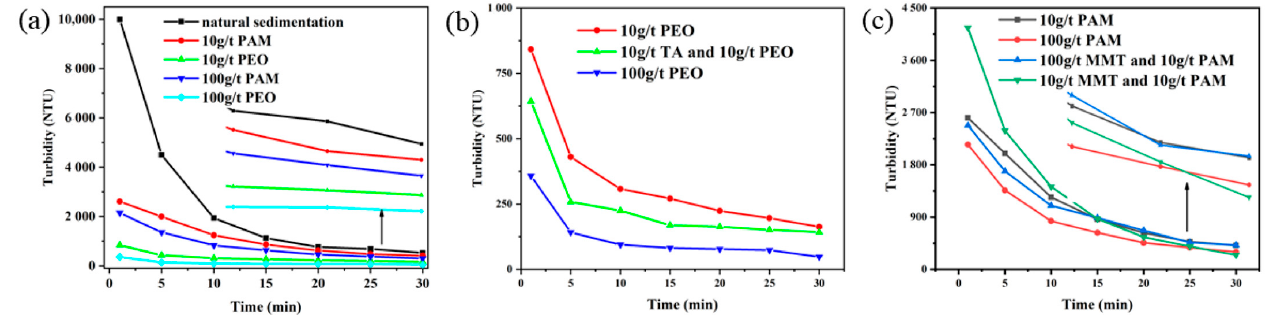
Figure 6. Supernatant turbidity of 10 wt.% -200-mesh quartz slurry during a 30-min sedimentation: ( a ) high molecule flocculants; ( b ) PEO and cofactor; ( c ) PAM and cofactor.